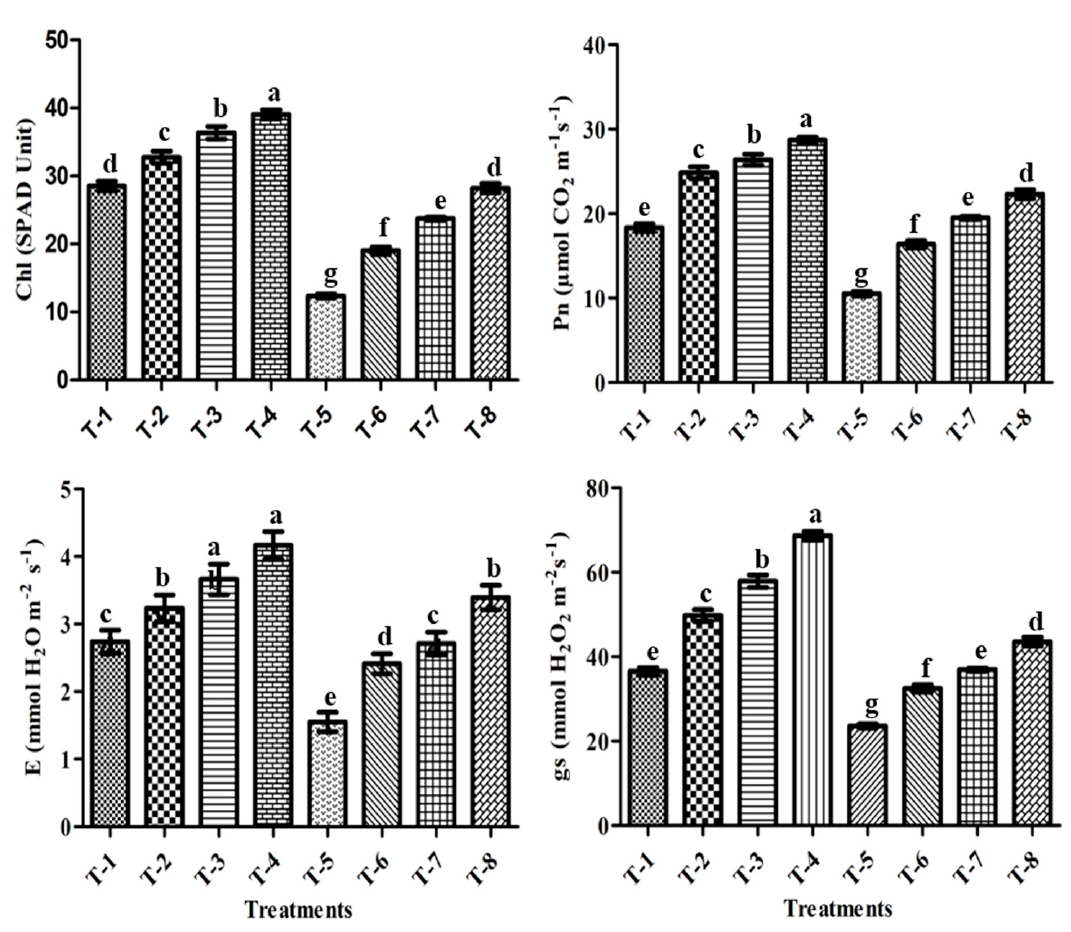
Figure 6. Effect of salt-tolerant PGPR ASN-1 and SNP on sugarcane photosynthesis attributes. T-1: Un-inoculated control; T-2: SNP; T-3: PGPR ASN-1; T-4: PGPR ASN-1 + SNP; T-5: NaCl (200 mM); T-6: NaCl + SNP; T-7: NaCl + PGPR ASN-1; T-8: NaCl + PGPR ASN-1 + SNP. Chl: chlorophyll; Pn : net photosynthesis rate; gs: stomata conductance; E: transpiration rate. The mean ± SE, n = 3 is represented. Letters on each column bar represent significant variances ( p < 0.05) after the DMRT test.